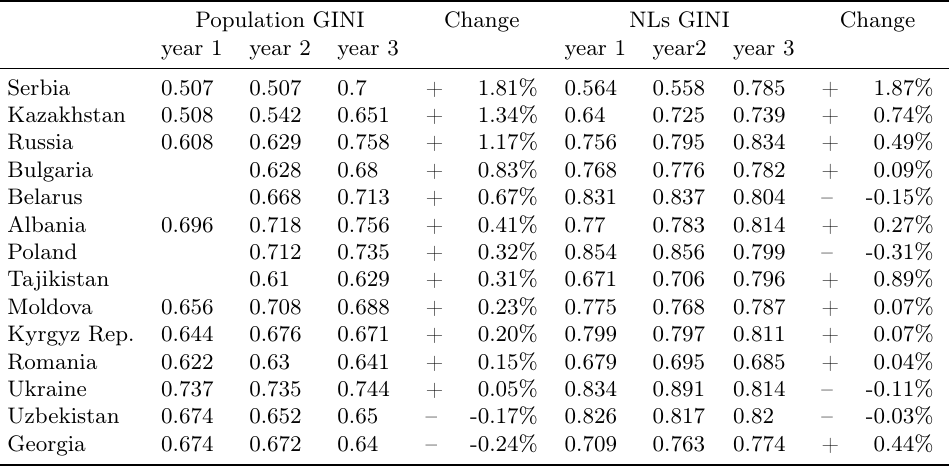
Table A.1: Concentration of Population and Economic